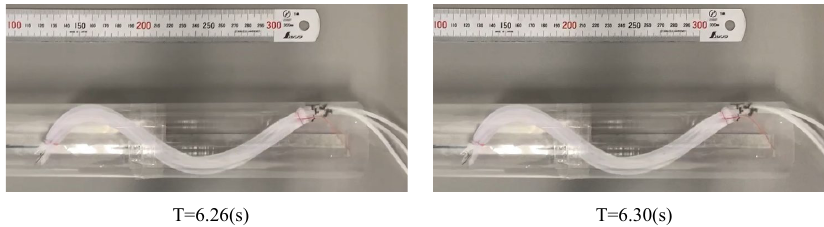
Figure 11. Experiments in which the device was driven with a period of 700 ms, a duty ratio of 0.47, and an air pressure of 0.14 MPa.